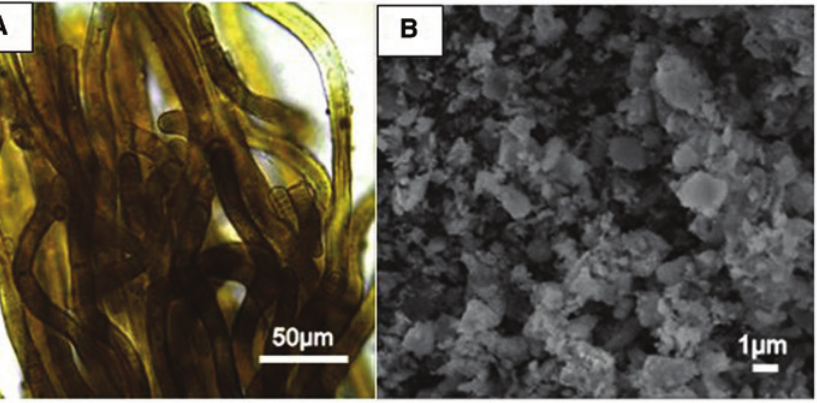
Figure 1: Algae and nanocomposite. (A) Optical microscopic image of Scytonema guyanense var. minus and (B) scanning electron microscopy (SEM)